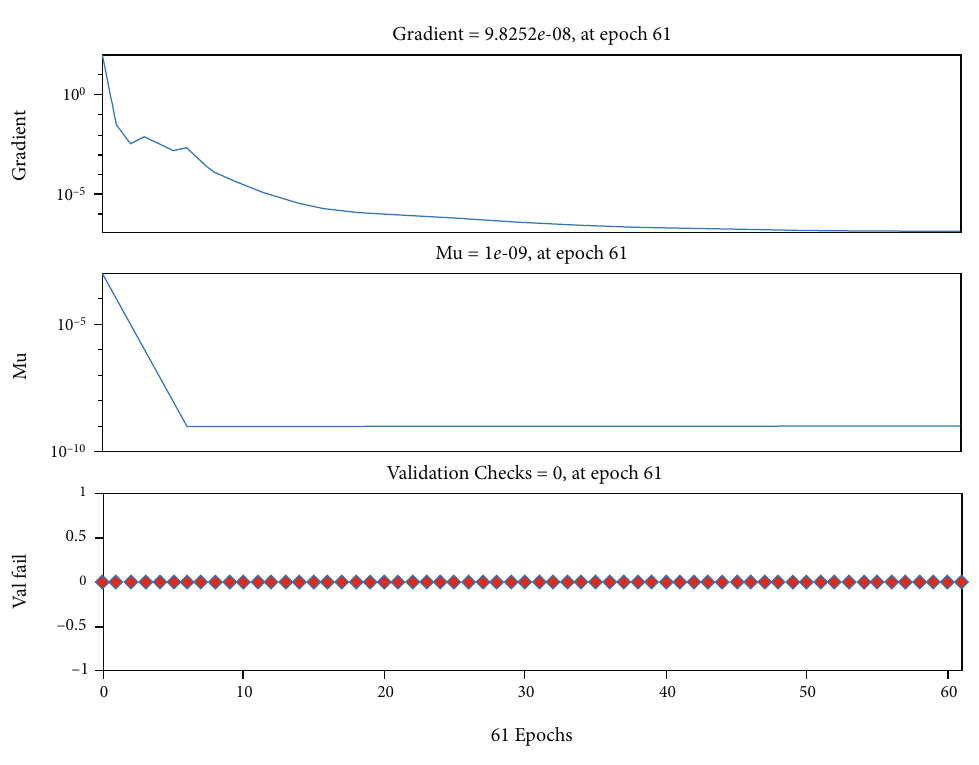
Figure 7: DNN-PV MPPT controller with training